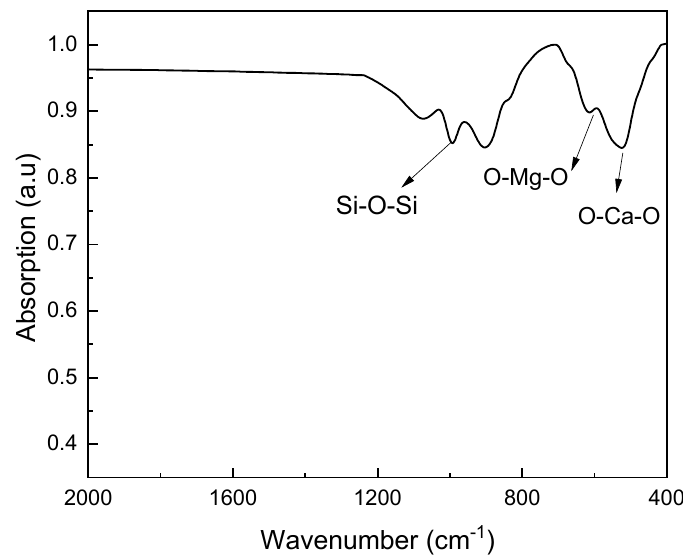
Figure 5. FTIR spectrum of diopside (DIO) nanoparticles.